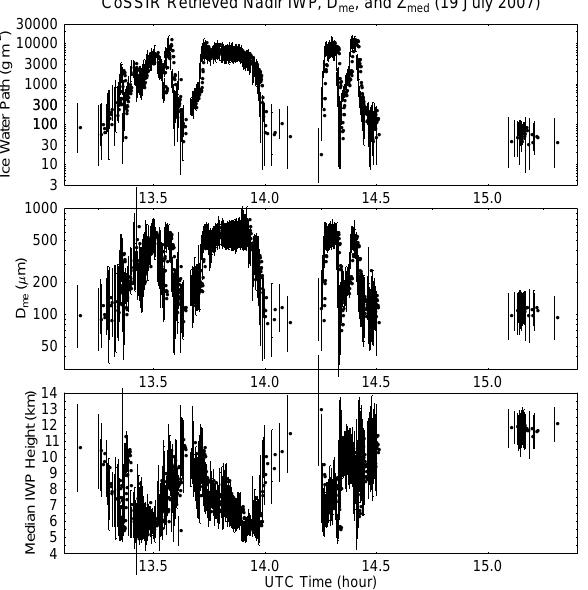
Fig. 7. CoSSIR brightness temperatures for four channels (top panel). Retrieved probability of ice cloud (middle panel). A dotted line at 0.95 probability is shown. Retrieved ice water path (bottom panel).